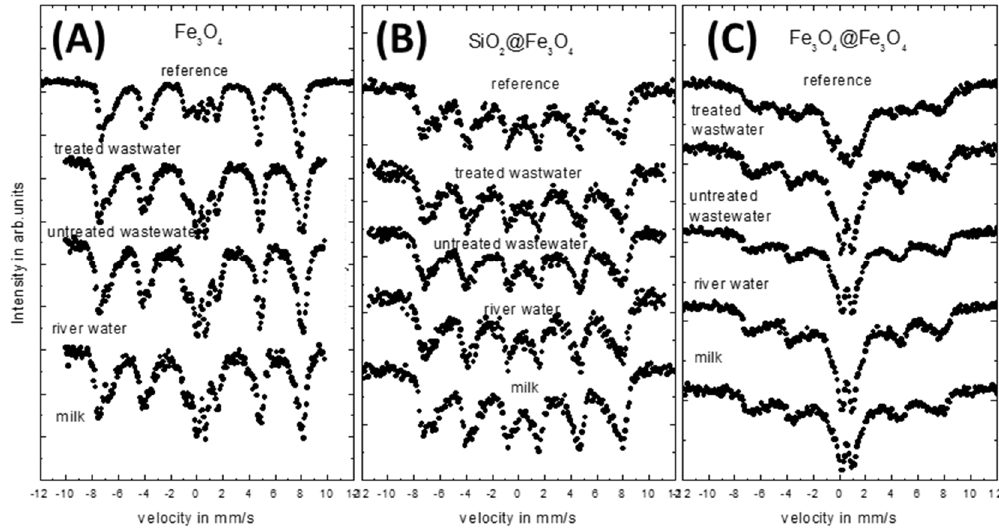
Figure 4. RT Mössbauer spectra of all tested types of nanoparticles wetted in various environmental solutions. ( A ) Fe 3 O 4 ; ( B ) SiO 2 @Fe 3 O 4 nanoparticles; ( C ) Fe 3 O 4 @Fe 3 O 4 nanoparticles.